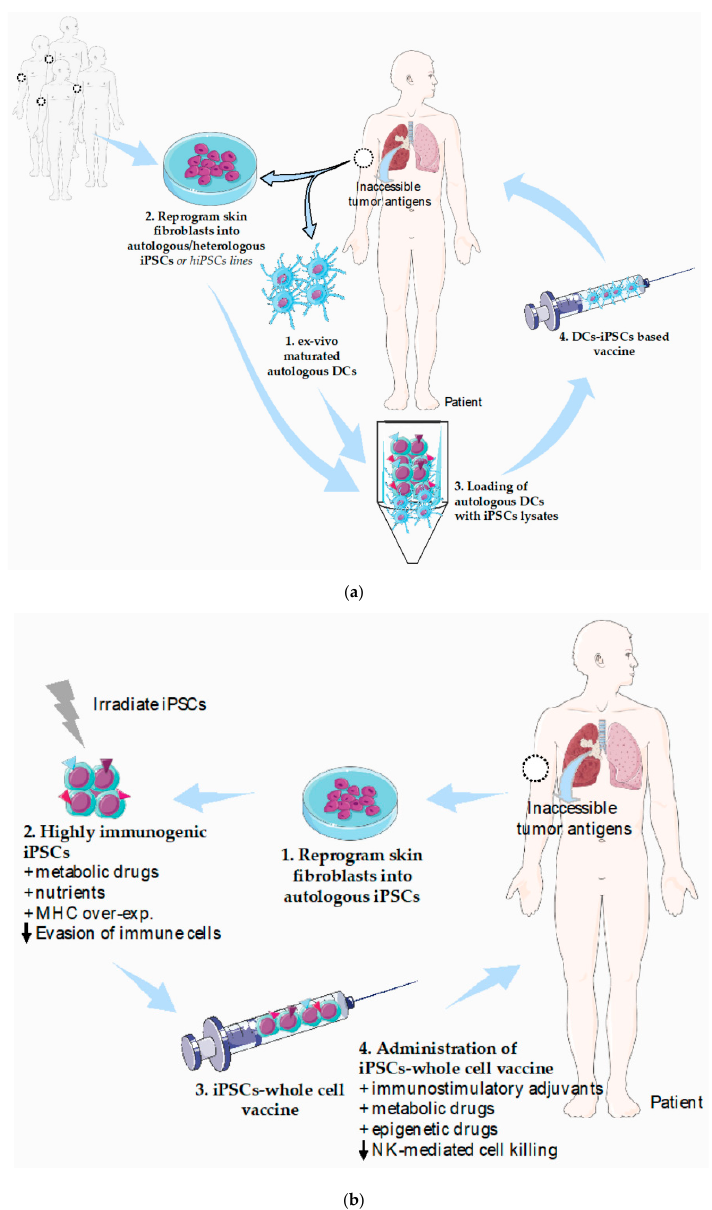
Figure 2. Potential strategies to refine iPSCs-based cancer vaccines. ( a ) Schematic illustration of the combination of iPSCs and DCs-based vaccines and application in cancer patients. Autologous DCs are obtained from peripheral blood (1) followed by adequate ex vivo DC maturation. A sample of skin (2) is used to obtain adult fibroblasts that will be reprogrammed into autologous iPSCs by the introduction of the four Yamanaka transcription factors or alternatively, established syngeneic human iPSCs lines could be used. (3) iPSCs are used to exogenously load autologous DCs ex vivo and the DCs-iPSCs based vaccines will be is administered in the cancer patient (4). ( b ) Schematic illustration of same strategies that could improve the e ffi cacy of autologous iPSCs-whole cell vaccines. Autologous skin-derived fibroblasts are reprogrammed into iPSCs (1) followed by ex-vivo treatments to enhance iPSCs immunogenicity and irradiation for safety (2). iPSCs-whole cell vaccines will be administered into cancer patients (3) in combination with cytotoxic T and APCs immunostimulatory and / or NKs-mediated cell killing inhibitory strategies (4). Abbreviations: APCs, antigen-presenting cells; DCs, dendritic cells; iPSCs, induced pluripotent stem cell; NKs, natural-killer cells. This figure was created using Servier Medical Art templates, which are licensed under a Creative Commons Attribution 3.0 Unported License; https: //